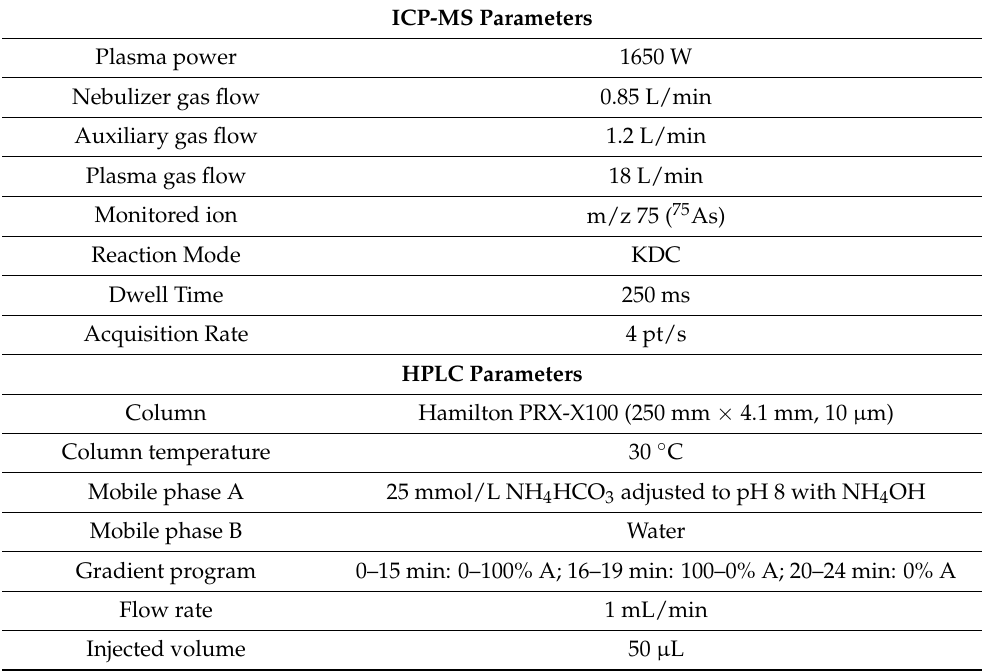
Table 1. Instrumental operating condition for